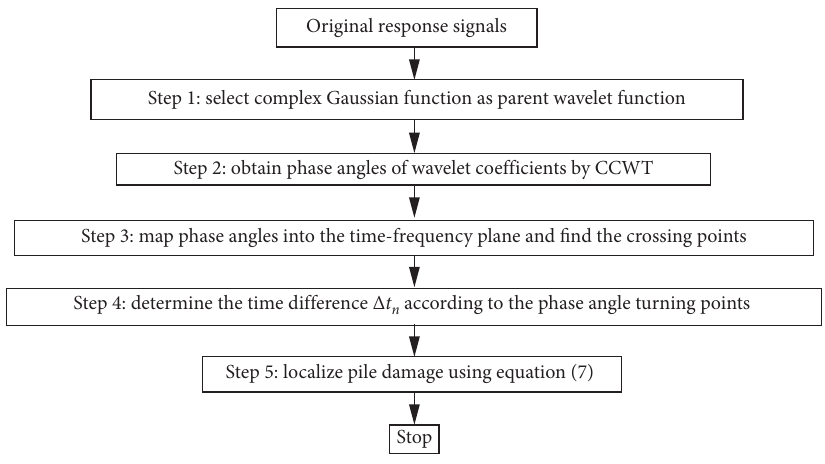
Figure 2: Flowchart of pile damage localization.